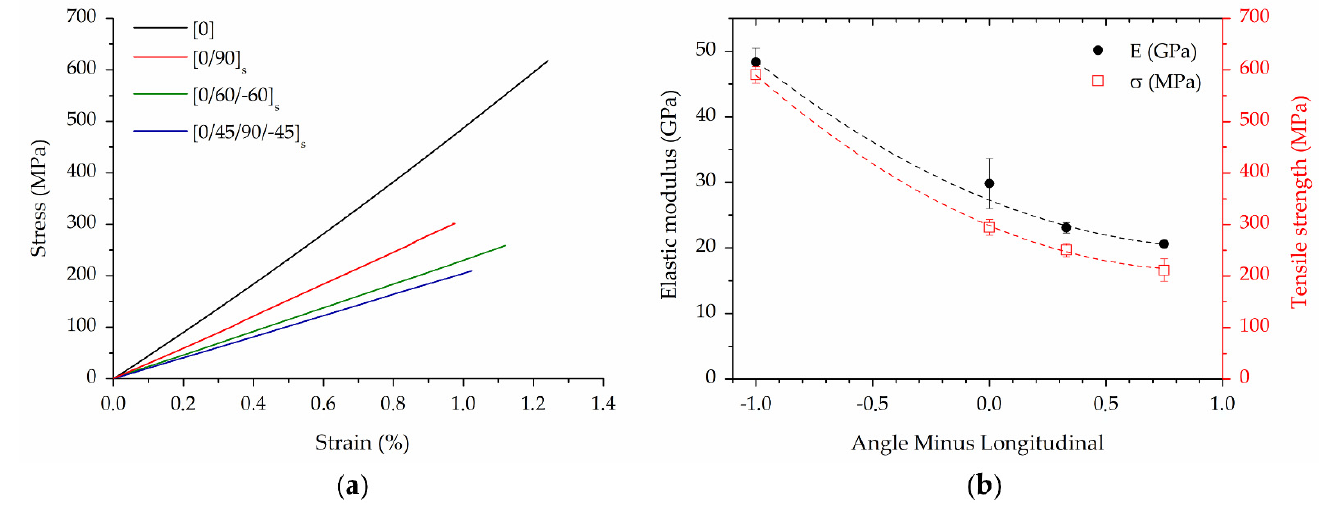
Figure 8. ( a ) Typical stress–strain curves of CCF/PA composites with various layups; ( b ) relationship between mechanical properties (elastic modulus and strength) and Angle Minus Longitudinal of the CCF/PA laminates.